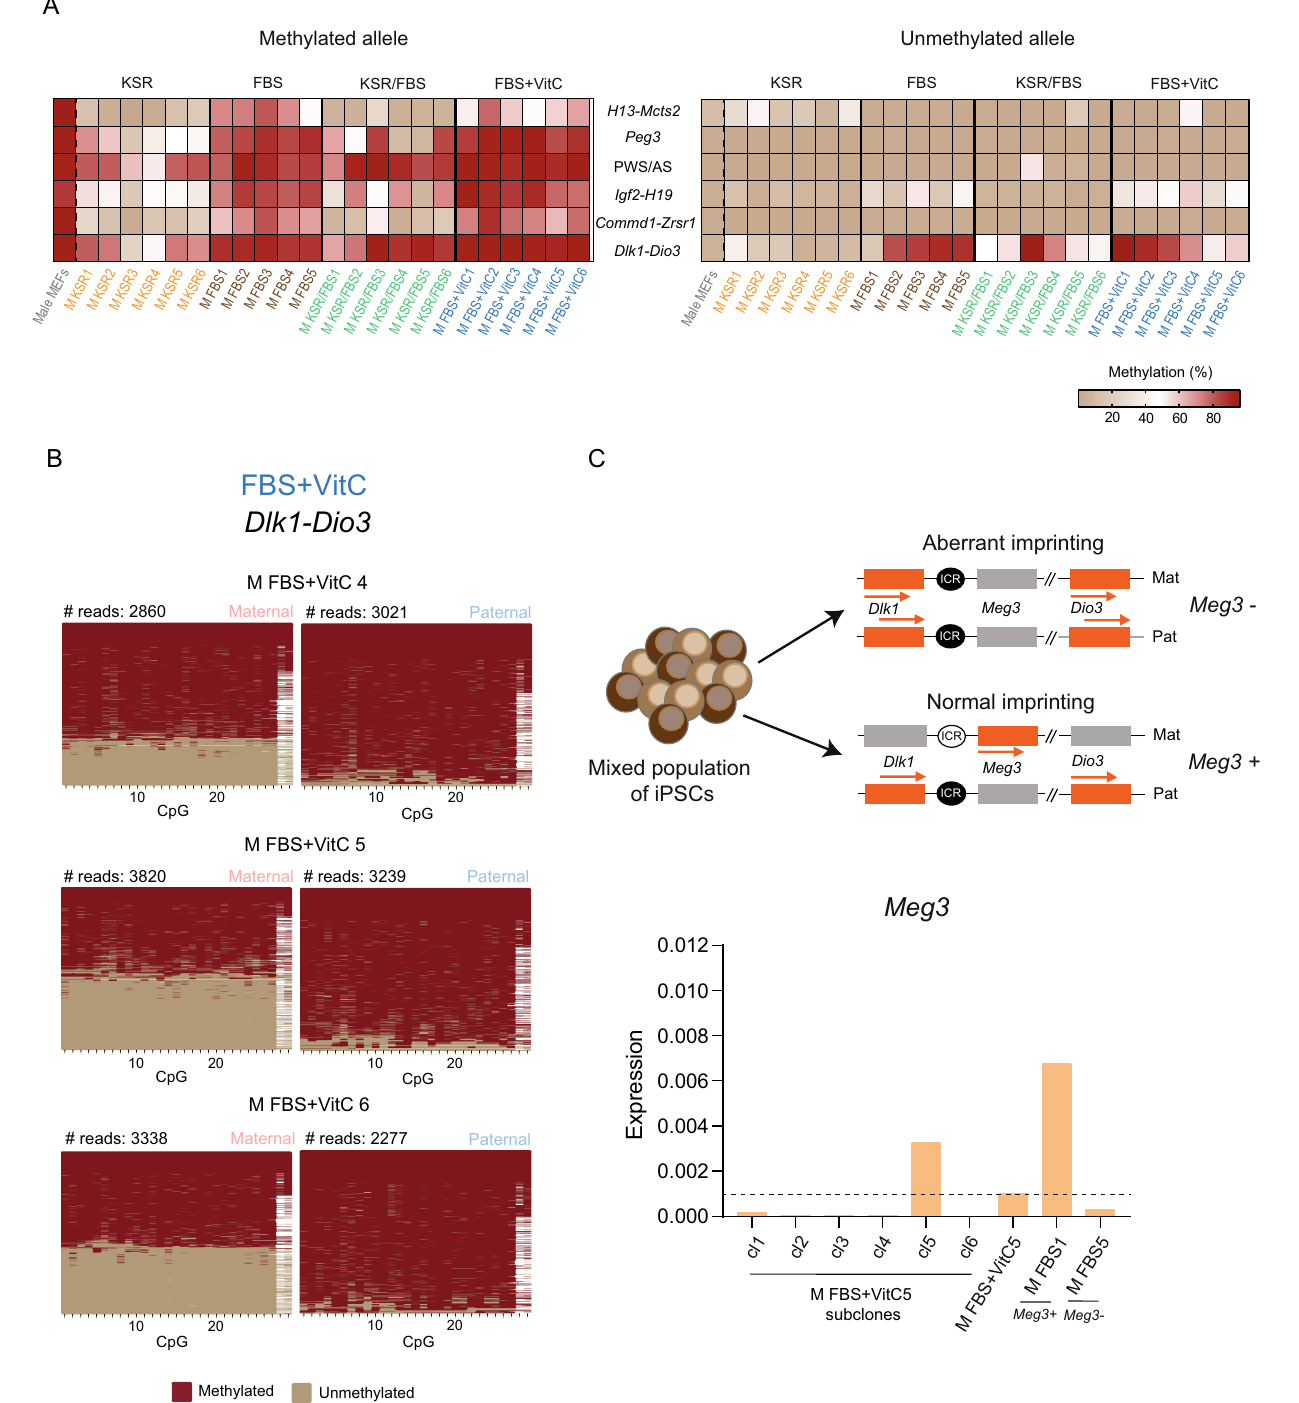
Fig. 7 | Imprinting fi delity in male KSR/FBS- and FBS+VitC-iPSCs. A Heatmap representing the percentage of DNA methylation at the methylated (left) and unmethylated (right) alleles of ICRs for male MEFs as well as male KSR- and FBS- iPSCs, KSR/FBS-iPSCs and FBS+VitC-iPSCs (note: same data as in Fig. 5A for male MEFs,KSR-andFBS-iPSCs).ICRsareshowninrowsandsamplesincolumns.Source data are provided as Supplementary Data 2. B Plots display methylated and unmethylated CpGs for each CpG position (in columns) in all the individual reads (in rows) for both maternal and paternal alleles of Dlk1-Dio3 imprinted locus in M FBS+VitC4-6 iPSCs. C Expression analysis of Meg3 gene in subclones of the FBS+ VitC5 iPSCs. On top, the scheme represents M FBS+VitC5 iPSCs with a mixed population of cells with normal and abnormal imprinting as estimated by the